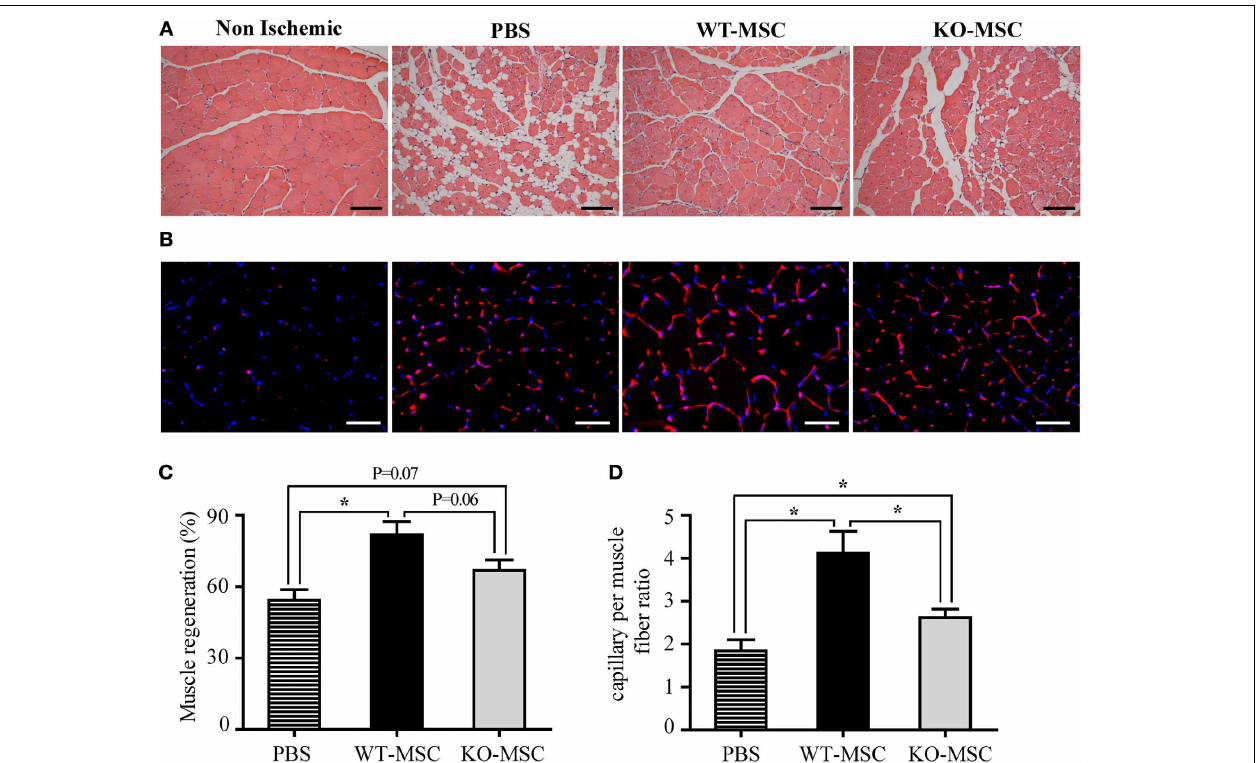
FIGURE 6 | Muscle regeneration and capillary formation are impaired in mice injected with CD13 KO MSC following ischemic injury. (A) Hematoxylin and eosin (H&E) staining of gastrocnemius muscle regeneration was confirmed by the presence of multiple, centrally located myocyte nuclei, 20X objective; Bar = 100 μ m. (B) Capillaries were visualized by immunofluorescent staining with CD31 (red) and nuclei with DAPI (blue); Objective, 40X objective; Bar = 50 μ m. (C) The area of the injured tissue was